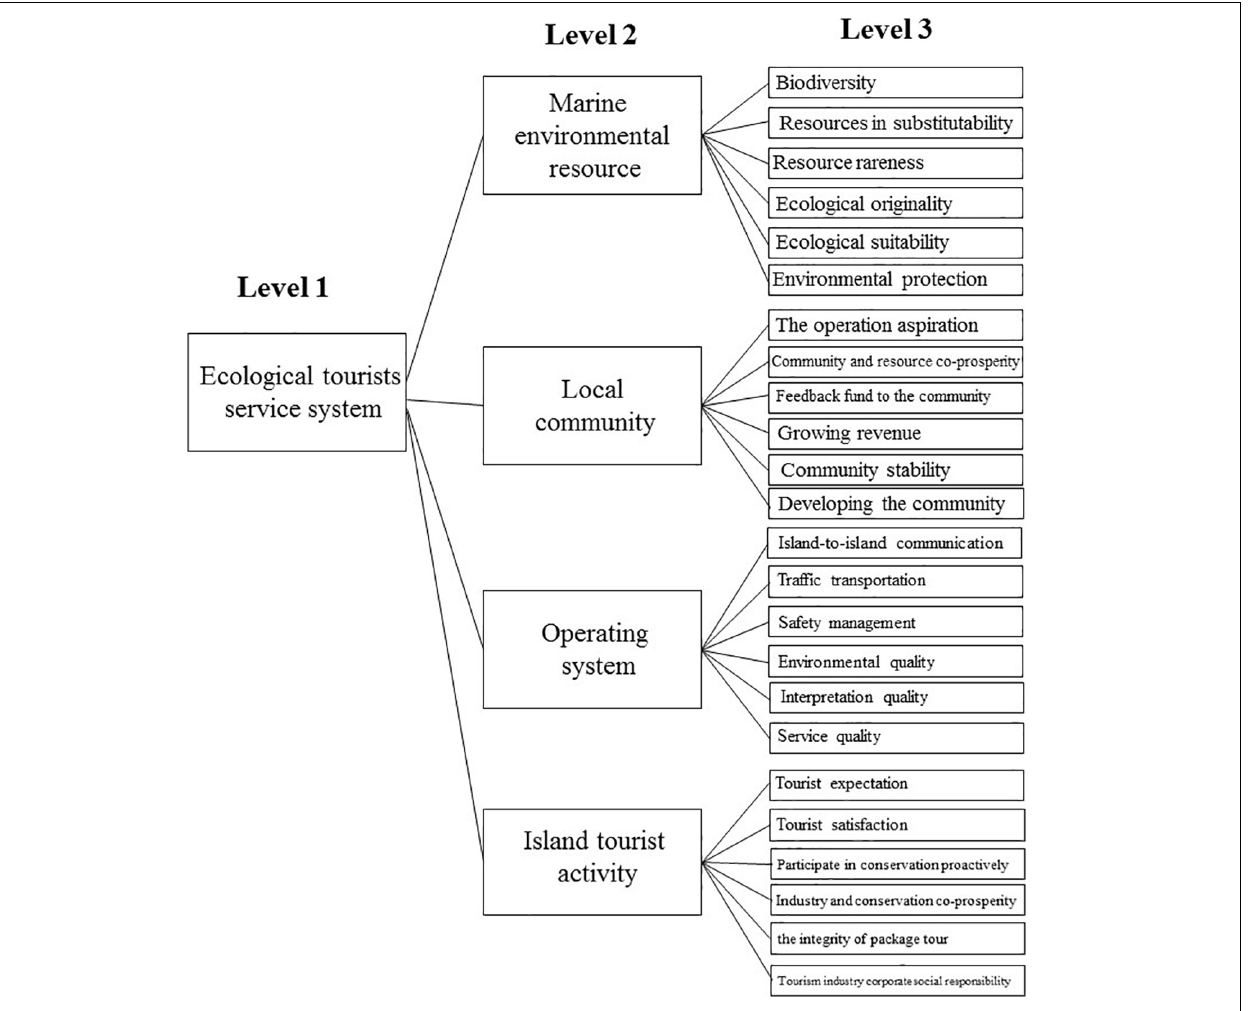
FIGURE 4 | Indicators of the Penghu National Scenic Area ecological tourism service system framework.